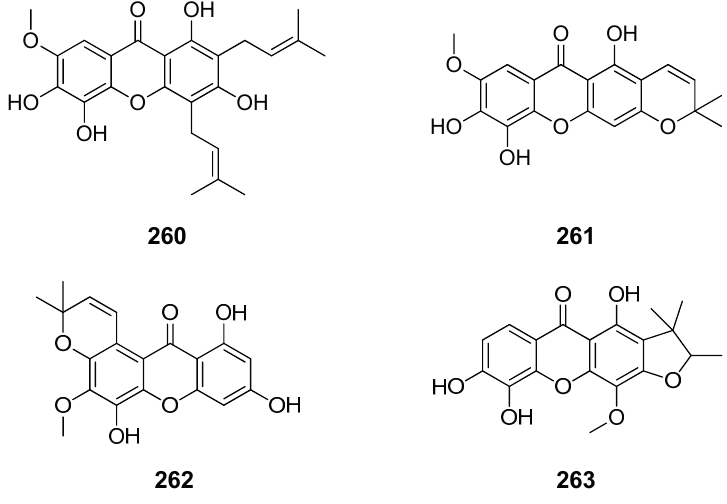
Figure 9. Chemical structures of tested pentaoxygenated and prenylated